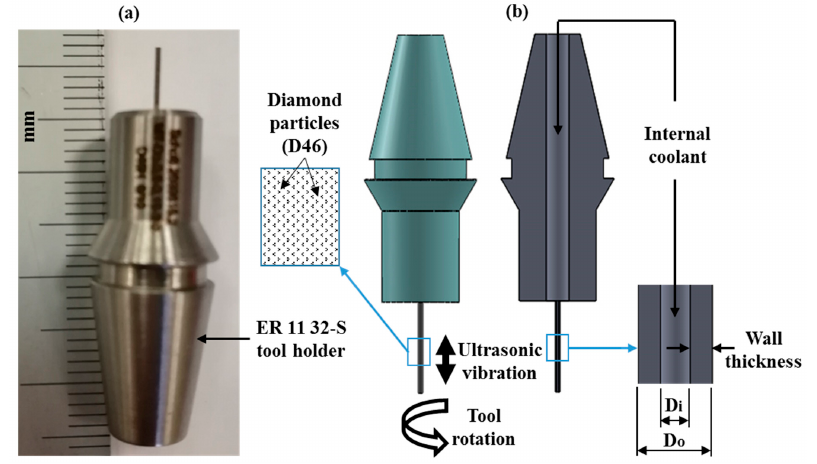
Figure 3. ( a ) Actual μ -RUM tool; ( b ) schematic of RUM tool.